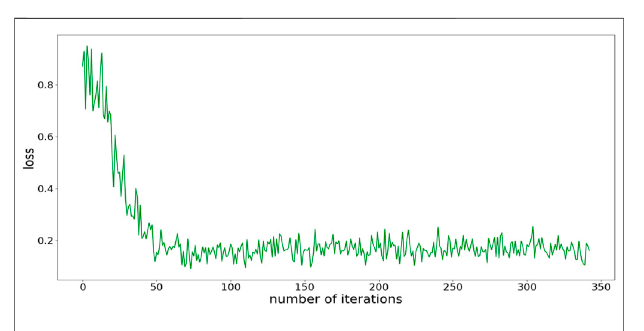
FIGURE 8 | Loss function curve of the algorithm.